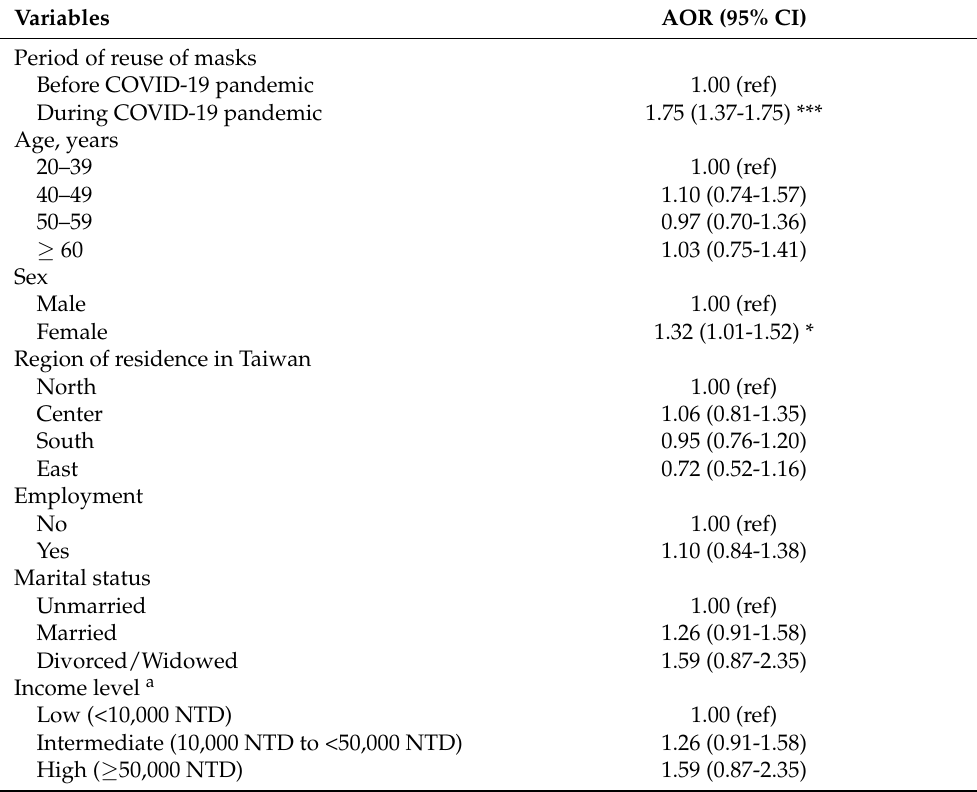
Table 3. Generalized estimating equation (GEE) model for the analysis of reuse of masks before and during the COVID-19 pandemic in Taiwan ( N =